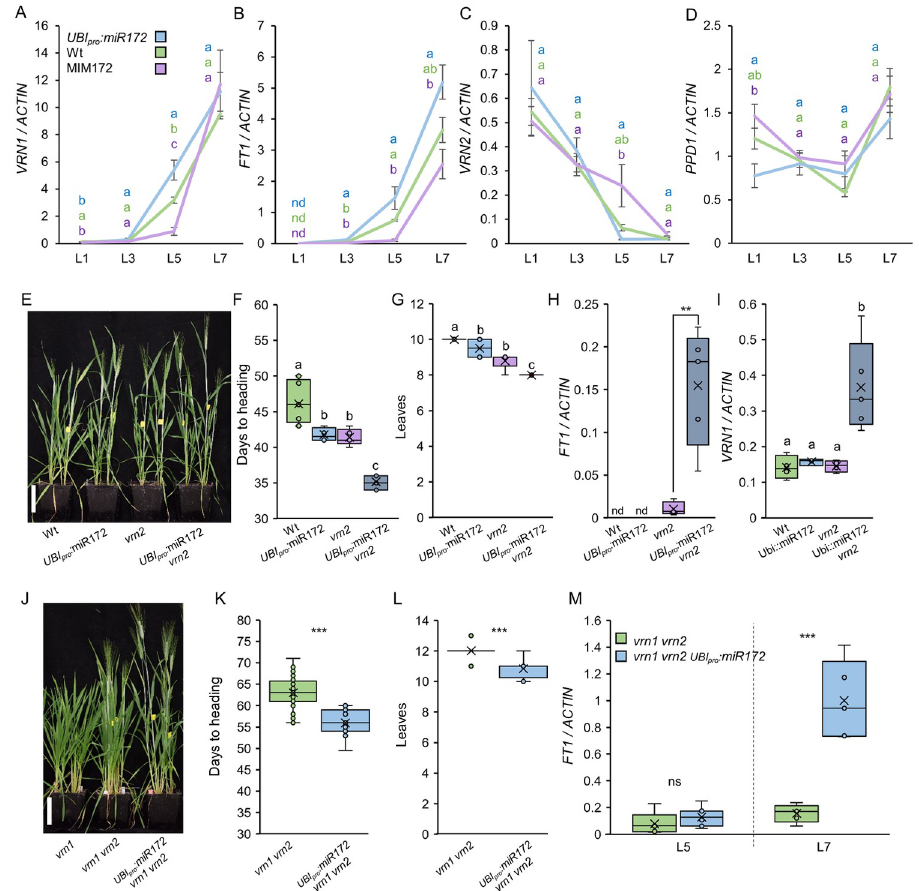
Fig 2. miR172 controls flowering through the regulation of FT1 expression in leaves. (A-D ) Expression levels of VRN1 ( A ), FT1 ( B ), VRN2 ( C ), and PPD1 ( D ) determined by qRT-PCR in the 1 st (L1), 3 rd (L3), 5 th (L5) and 7 th (L7) leaves of UBI : miR172 , wild type Kronos (Wt) and MIM172 plants grown under LD. ACTIN was used as internal pro reference. Data correspond to four independent biological replicates. ( E-I ) Population segregating for wild type Kronos (Wt), UBI pro : miR172 , vrn2 and UBI pro : miR172 vrn2 plants grown under LD. ( E ) Six-week-old plants. Scale bar = 10 cm. ( F-G ) Box plots showing days to heading ( F ; n � 4) and total number of leaves produced by the main tiller ( G ; n � 4). ( H-I ) Box plots showing FT1 ( H ) and VRN1 ( I ) expression levels determined by qRT-PCR in the first leaves. ACTIN was used as internal reference. Data correspond to four independent biological replicates. ( J ) Nine- week-old vrn1 null, vrn1 vrn2 combined mutant and vrn1 vrn2 UBI pro : miR172 plants growing under LD. Scale : miR172 plants grown under LD. ( K-L ) bar = 10 cm. ( K-M ) vrn1 vrn2 combined mutant and vrn1 vrn2 UBI pro Box plots showing days to heading ( K ; n � 11) and number of leaves produced by the main tiller ( L ; n � 12). ( M ) Box plots showing FT1 expression levels determined by qRT-PCR in the 5 th (L5) and 7 th (L7) leaves. ACTIN was used as internal reference. Data correspond to five independent biological replicates. Different letters above the box plots indicate significant differences based on Tukey tests ( P < 0.05) in panels ( A-D ), ( F ) and ( I ), on Kruskal-Wallis non- parametric testes in ( G ) and ( L ), and on t- tests in panels ( H ), ( K ) and ( M ) (Data B in S1 Data). ns = not significant, � = P < 0.05, �� = P < 0.01, ��� = P < 0.001. The color of the letters in A-D correspond to the color of the genotypes. amplify FT1 transcripts in wild type or UBI : miR172 first leaf samples, but we detected a low pro : miR172 vrn2 showed a sig- FT1 expression level in vrn2 mutants (Fig 2H). Interestingly, UBI pro nificant increase in FT1 expression compared to the vrn2 mutant (Fig 2H). VRN1 expression was detected in all lines and no difference was observed between wild type, UBI : miR172 and pro : miR172 vrn2 vrn2 samples. However, VRN1 expression was significantly higher in UBI pro plants (Fig 2I). These results indicate that overexpression of miR172 can promote FT1 and VRN1 expression in the absence of VRN2 .